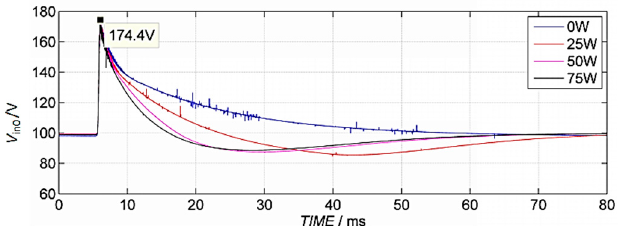
Figure 10. The simulated waveforms of the input voltages of module 0 with hard bypass.